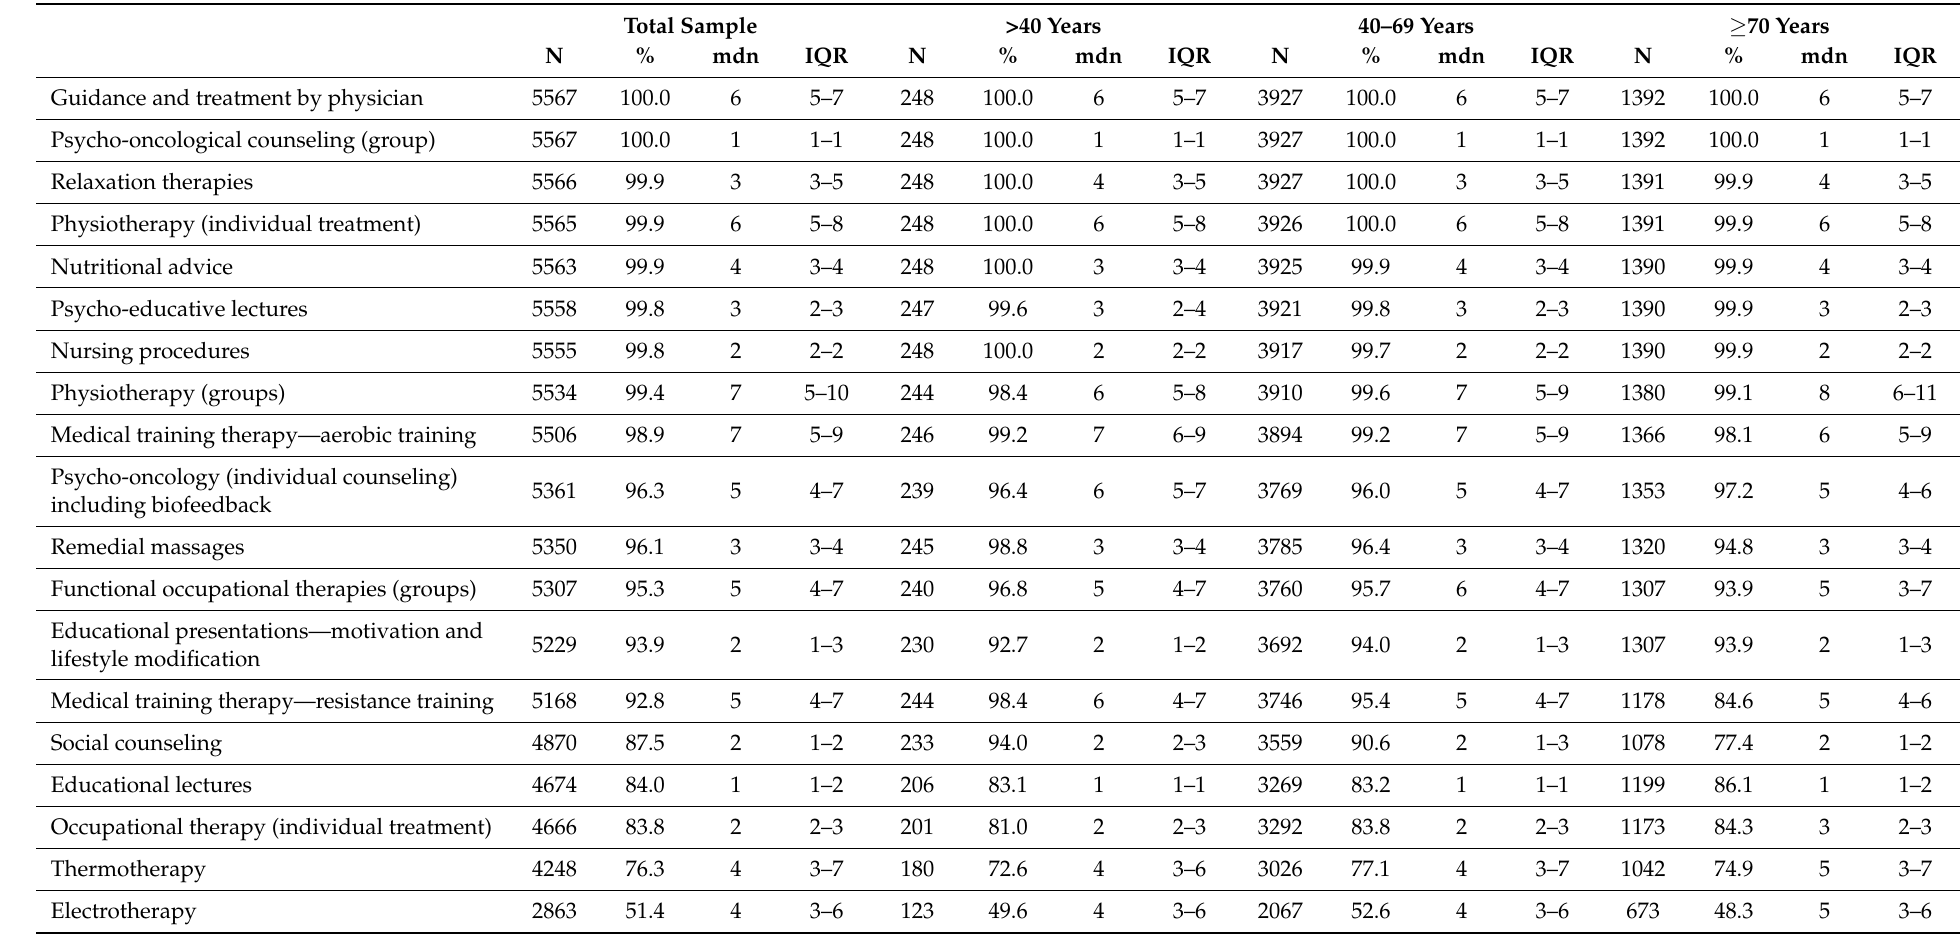
Table 2. Overview of treatment modalities across age groups per patient during